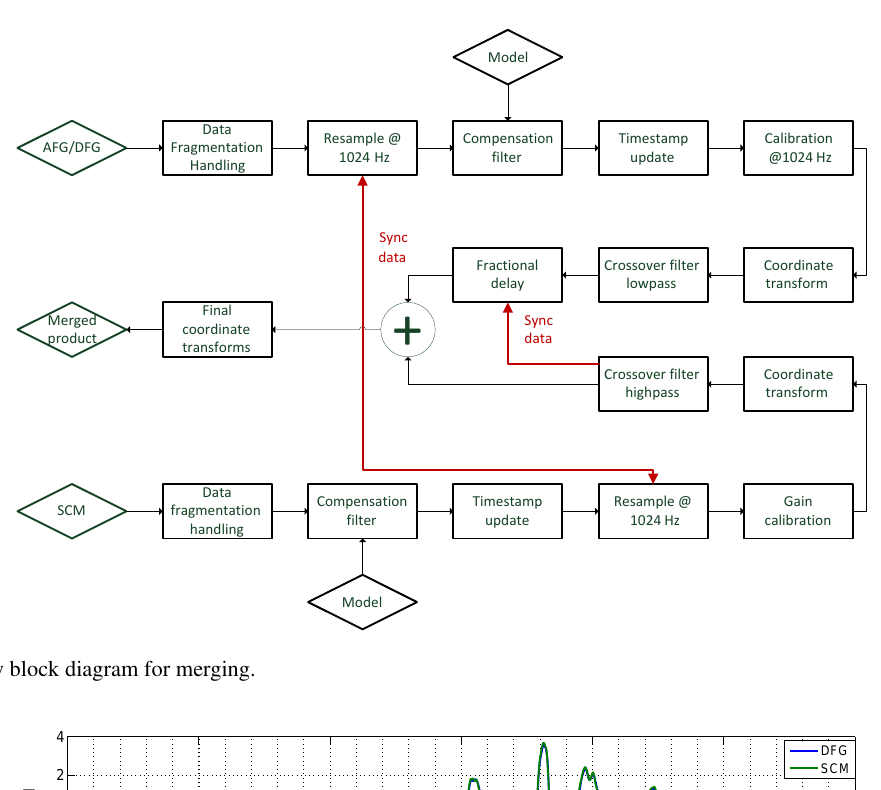
Figure 10. Data flow block diagram for merging.